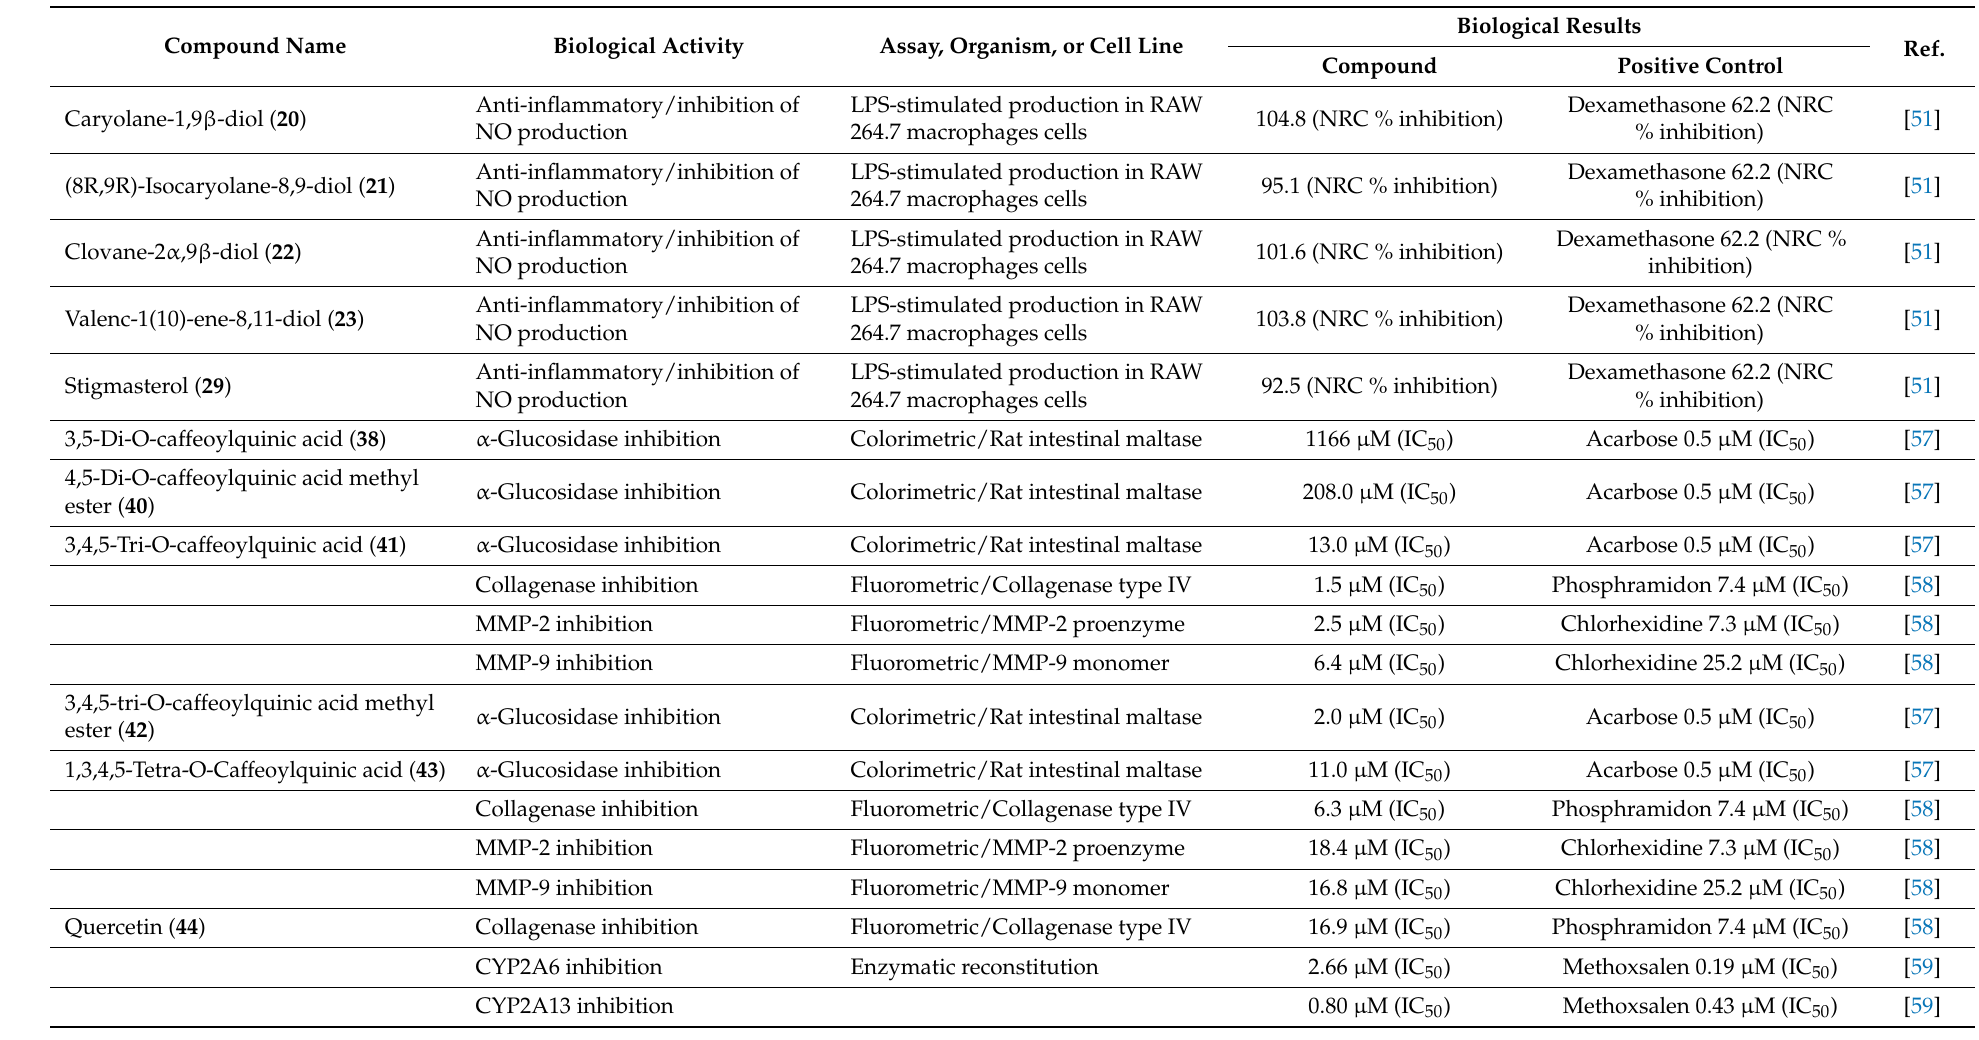
Table 3. Biological activity of reported metabolites from Pluchea indica